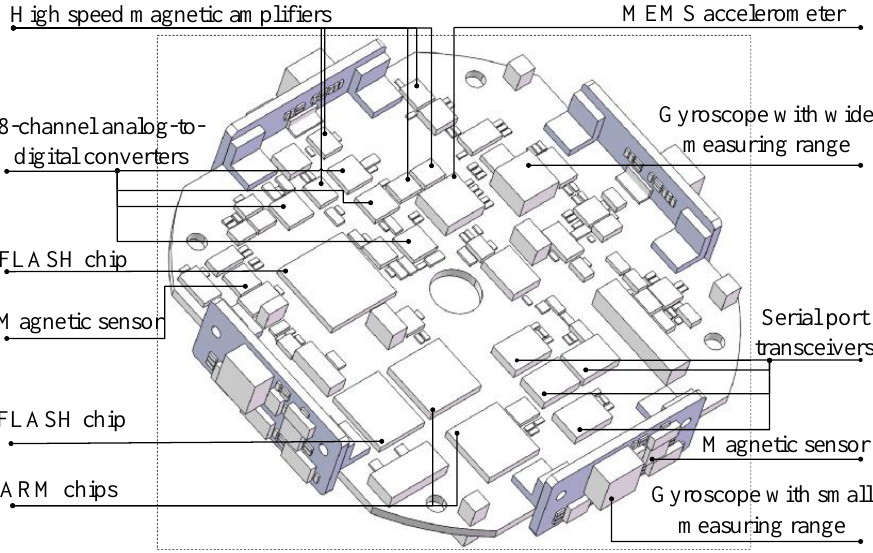
Figure 13. The structure of the parachute scanning platform attitude measurement